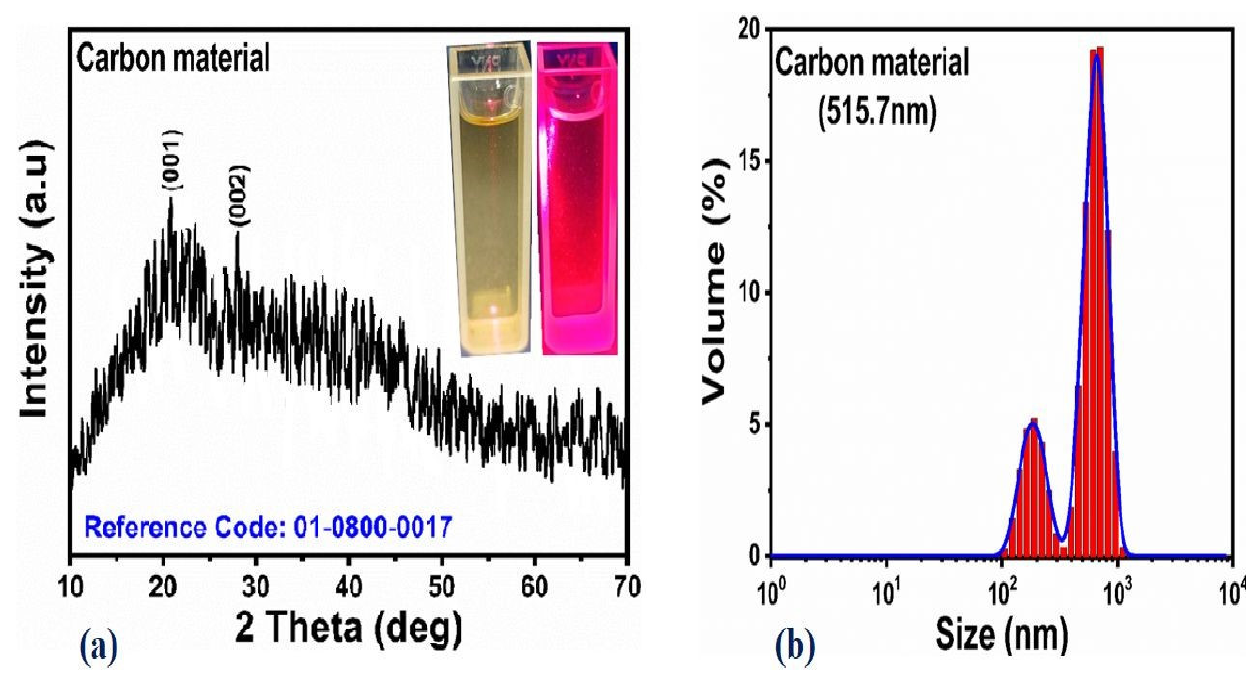
Figure 2. ( a ) Diffraction patterns of as-prepared carbon material from phalsa using powder; the inset represents a camera image of the luminescent properties of the as-prepared carbon material. ( b ) DLS analysis of as prepared carbon material using zeta nanosizer.